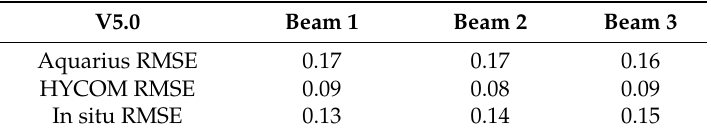
Table 1. Estimated Root Mean Square Error (RMSE) in the unit of psu for each data type based on the triple point analysis of co-located point